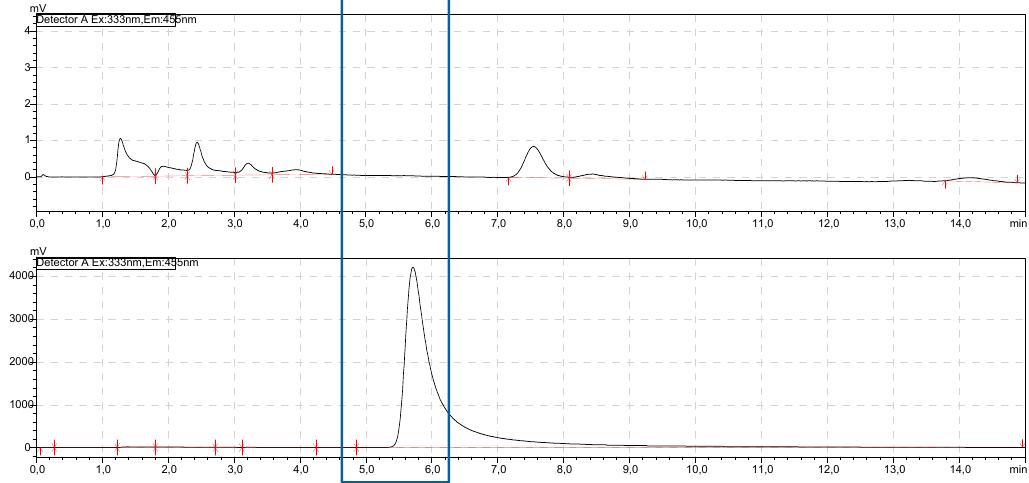
Figure 6. Chromatogram comparison of o-Phtadialdehyde (OPA) (above) and alendronate (AL)–OPA (below). Fluorescence detector: 333 nm excitation and 455 nm emission.